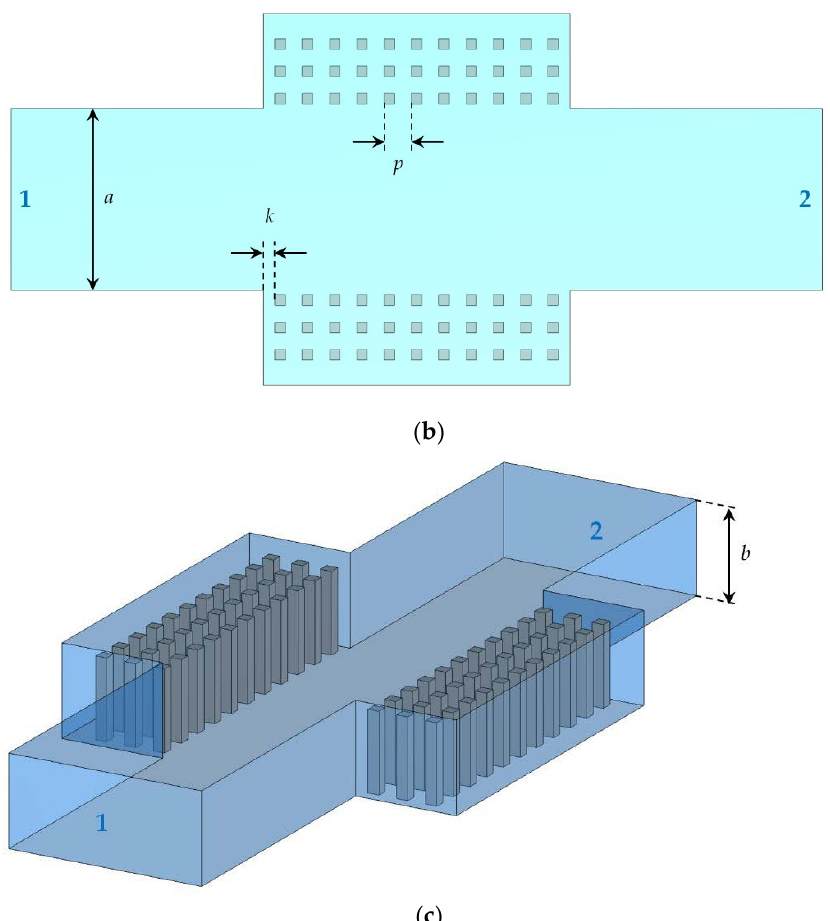
Figure 1. Groove gap waveguide geometry. ( a ) Cross section. ( b ) Top view. ( c ) 3D view.